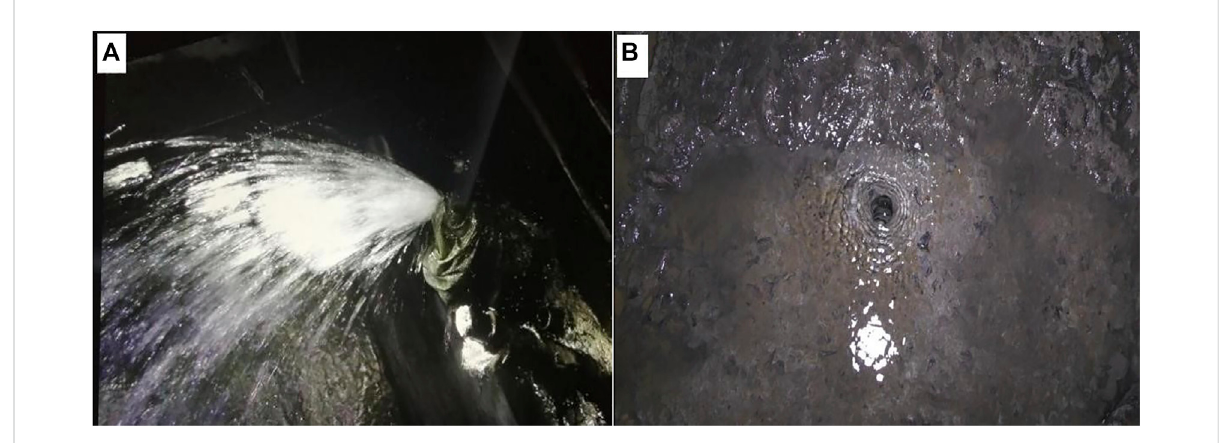
FIGURE 3 Groundwater leakage before and after grouting, (A) Water fl owing out of a single hole placed at 510 m – 670 m segment, with a rate of up to 60 m 3 /h before grouting, (B) Characteristics of leakage after grouting.